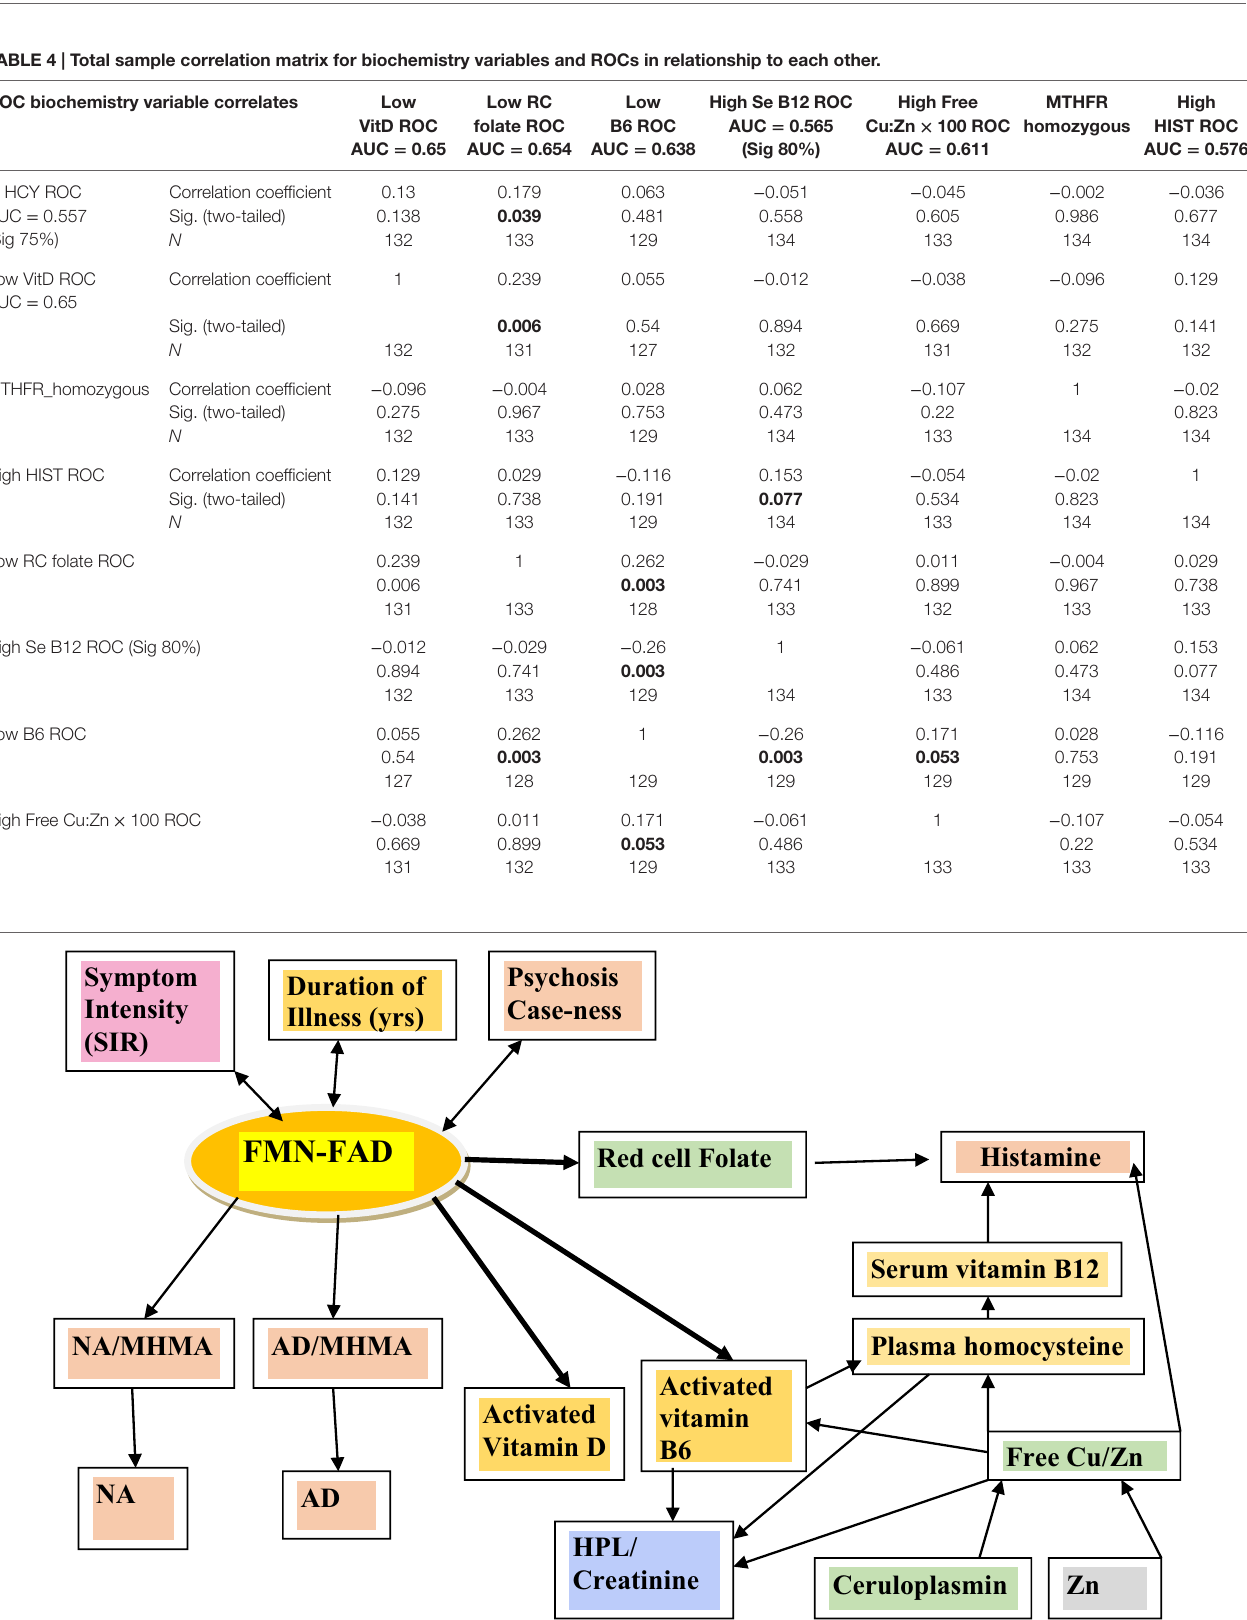
FigUre 2 | Variables examined by seM analysis in the context of their relationship within the biochemical pathways of interest